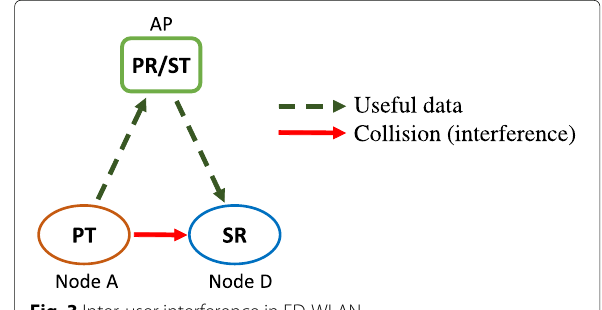
Fig. 3 Inter-user interference in